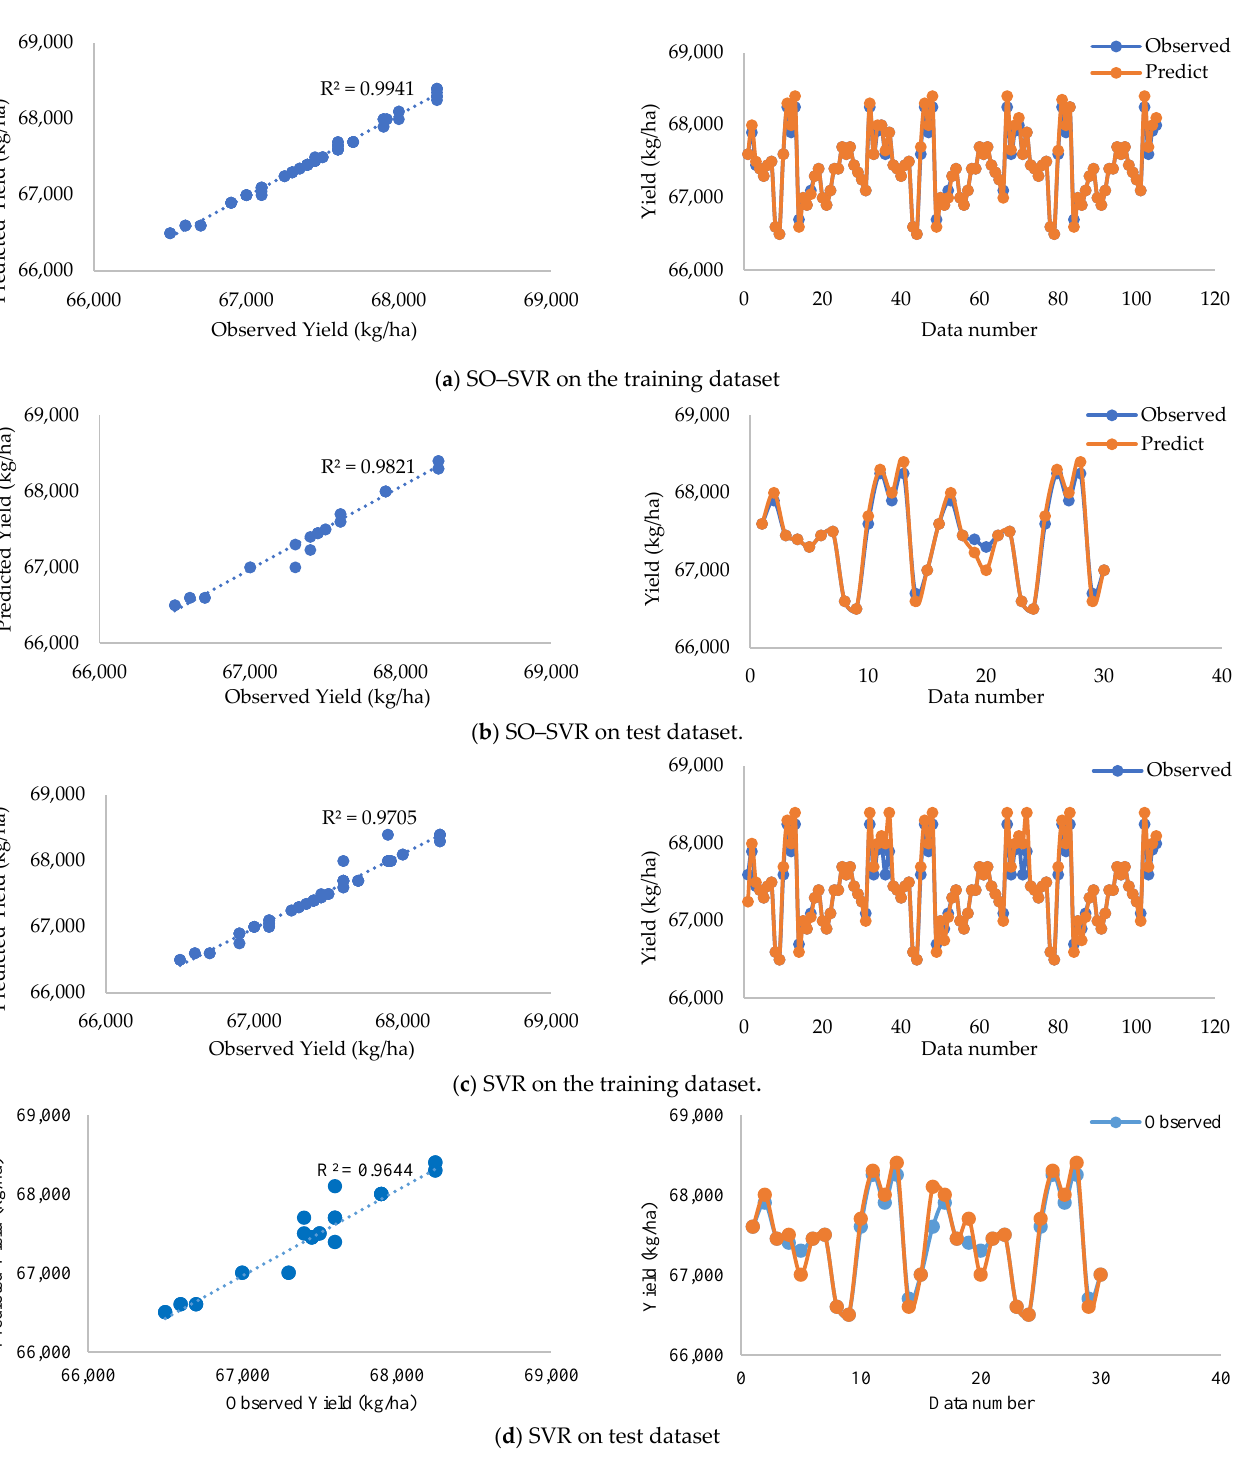
Figure 7. ( a – d ) Comparison of predicted yield with observed results in the training and test stages.